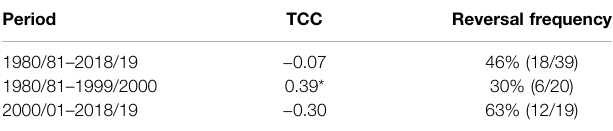
TABLE 1 | Temporal correlation coef fi cient (TCC) and reversal frequency of the Siberian high intensity index between December and January. Period